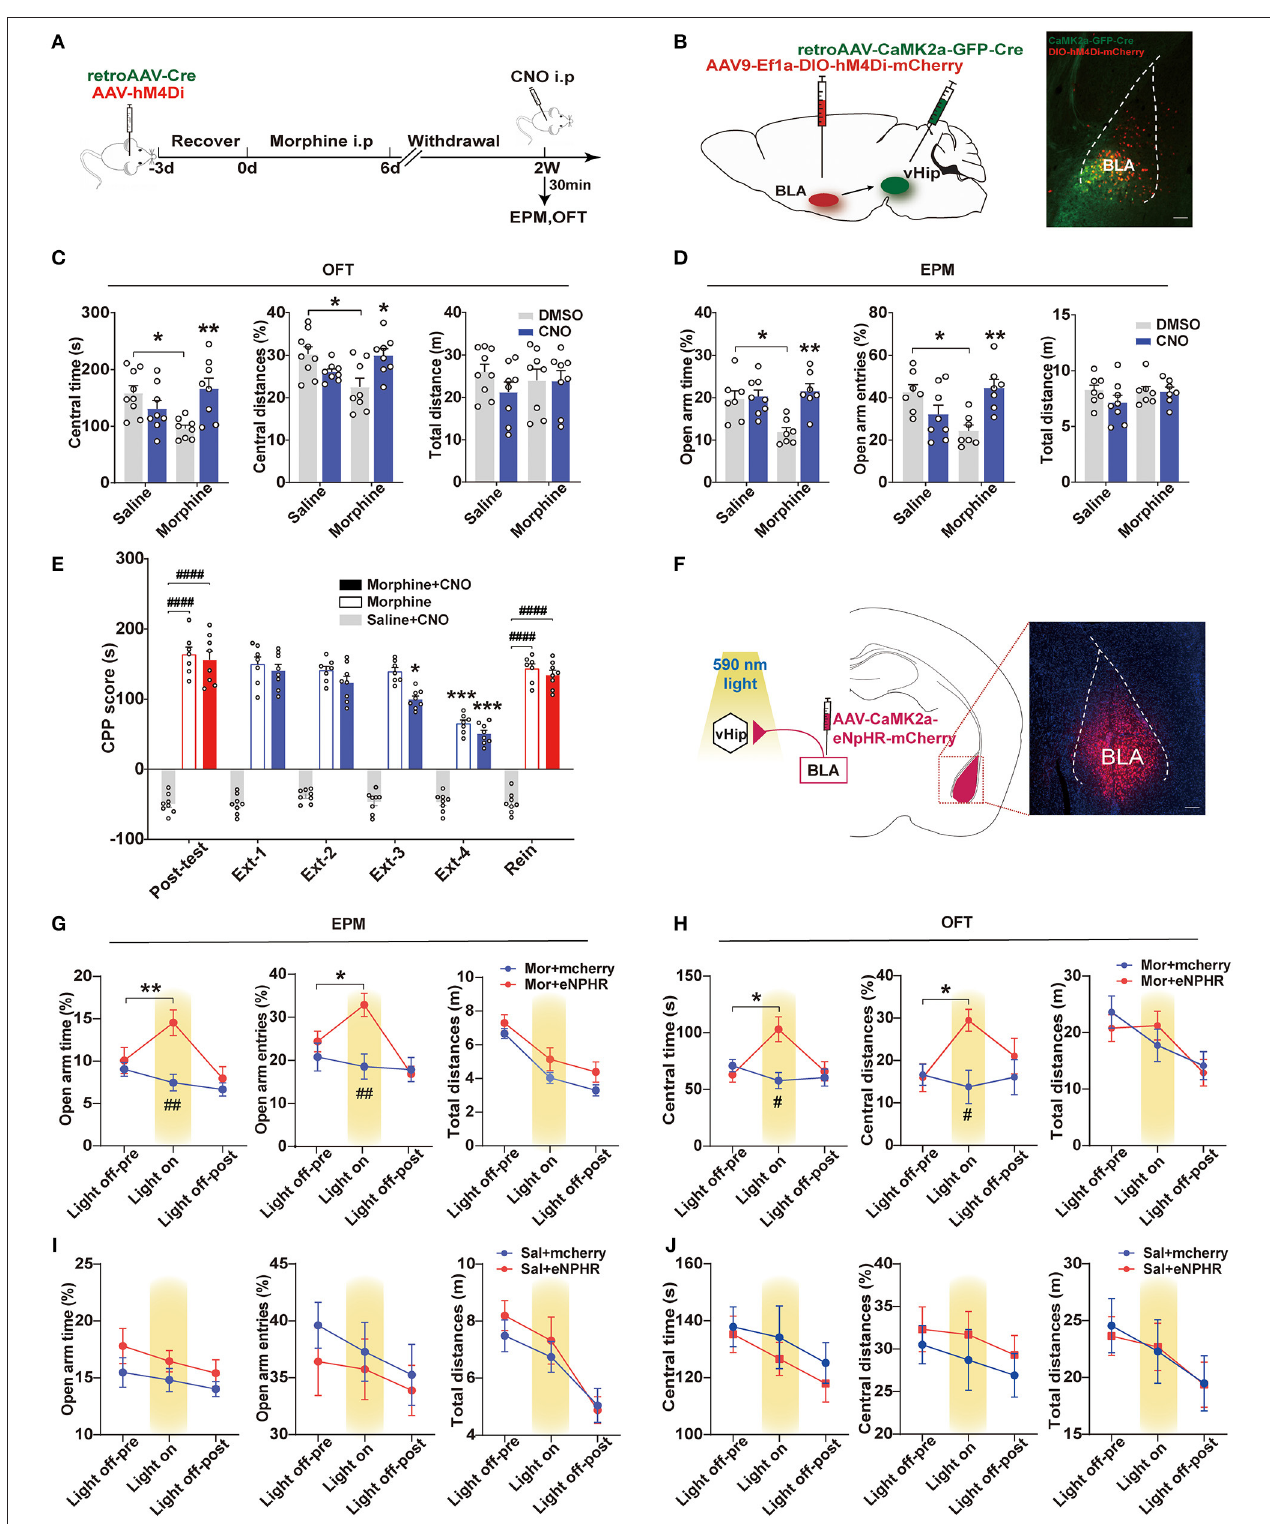
FIGURE 3 | BLA to vHip projections regulate anxiety-like behavior in morphine-withdrawn mice. (A–E) Chemogenetic experiment. (A) Workflow for the chemogenetic experiment. (B) Schematic (left) and representative image (right) of chemogenetic virus injection. Scale bar: 200 µ m. (C) The Mor-A × CNO mice exhibited